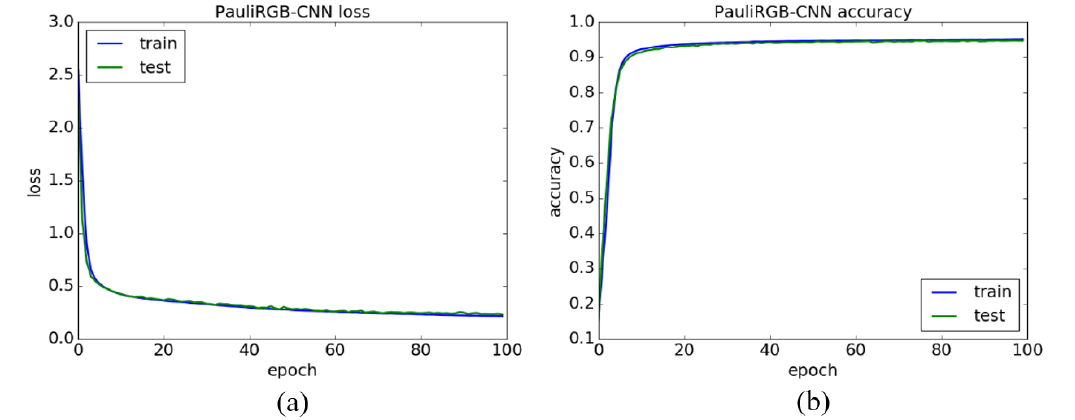
Figure 6. ( a ) Loss curve of the PauliRGB-CNN; ( b ) accuracy curve of the PauliRGB-CNN.